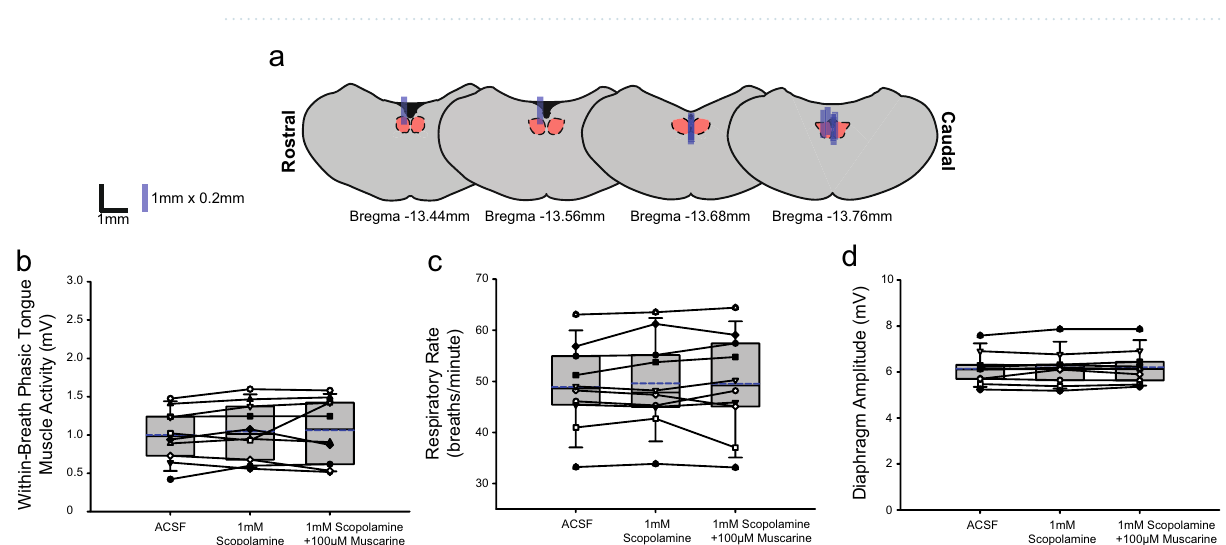
Figure 11. Group data from Protocol 3.2a : Microperfusion of 10 μM atropine into the HMN with and without co-application of muscarine (n = 8). Schematic representations of coronal sections of medulla illustrating the distribution of probe sites across all experiments ( a ). Drawn to scale, the blue rectangles represent reconstruction of the sites of the microdialysis probes; overlap obscures some of the individual probe sites. Box and whisker plots show individual and group data (median [dashed line], mean [solid line] and 25th and 75th percentiles) for within-breath phasic tongue muscle activity ( b ), respiratory rate ( c ), and diaphragm amplitude ( d ). Each animal is indicated by a different symbol. *, indicates p < 0.05 compared to baseline ACSF controls.